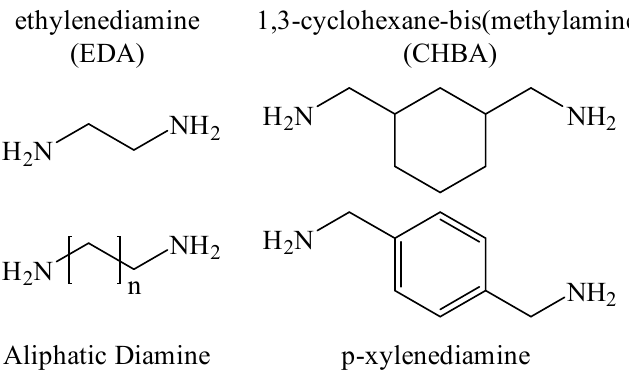
Figure 10. Diamine monomers used in the literature.